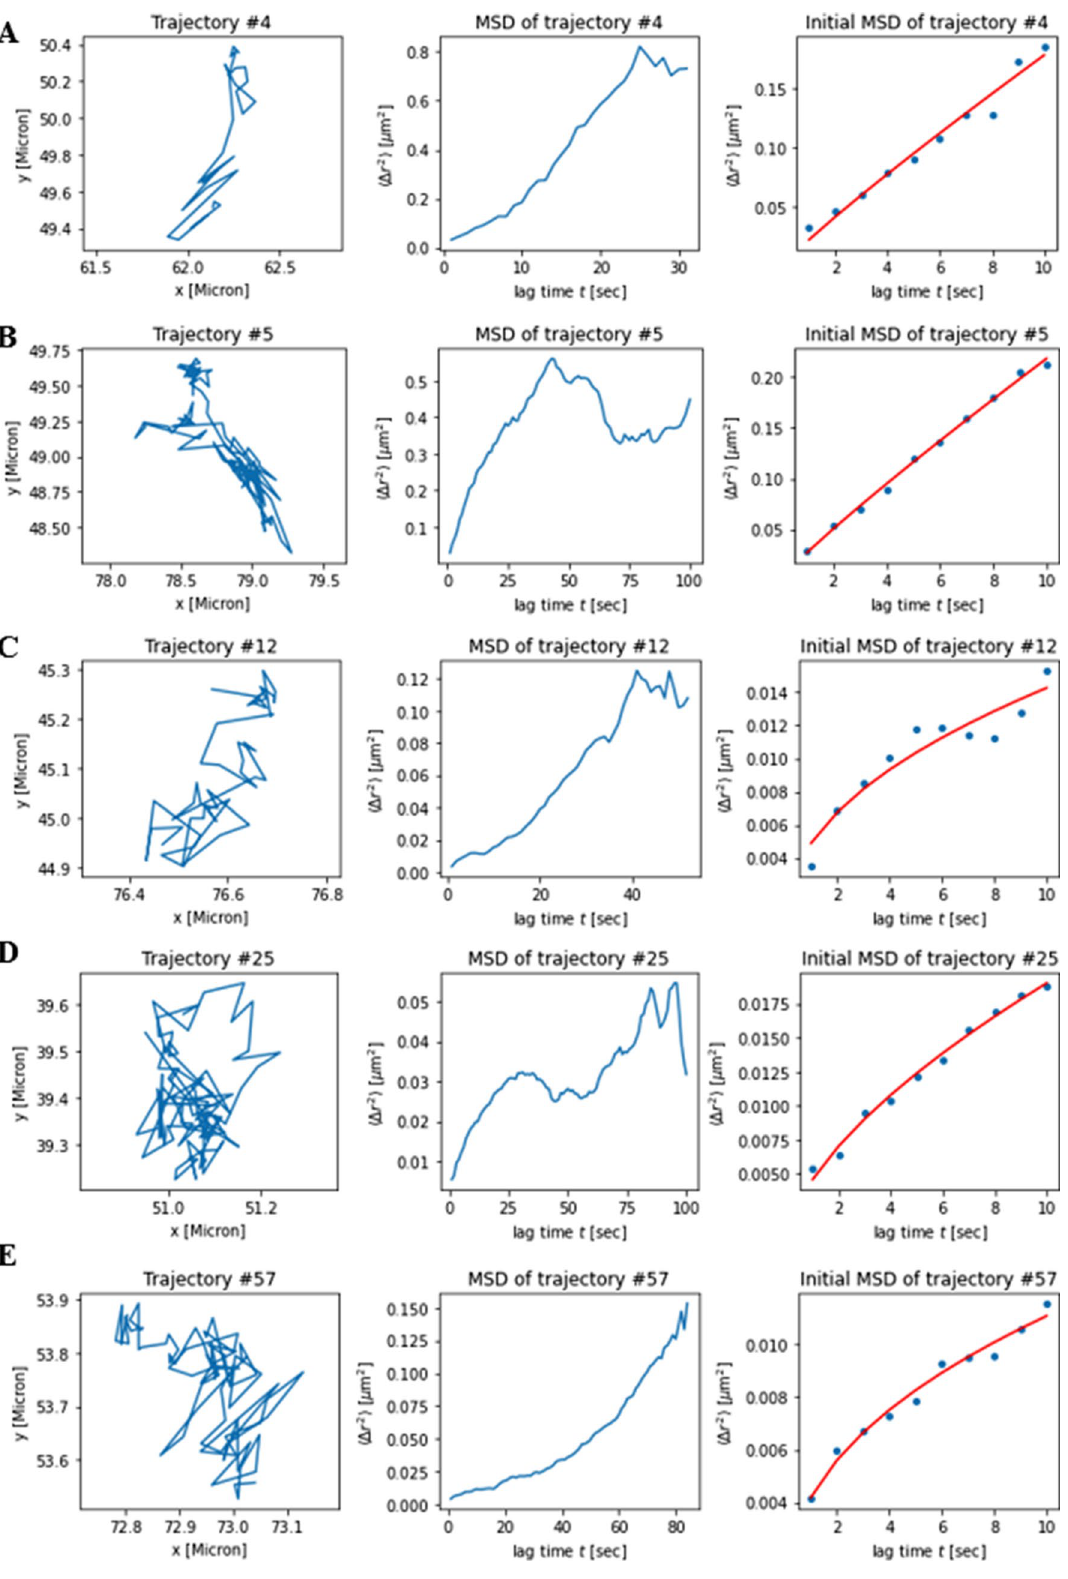
Figure 9. Selected trajectories of dynamic membrane contact sites and their analysis. MCSs identified in a single cell (‘cell1’, compare Fig. 7–8) were analyzed by single particle tracking revealing their trajectories (left panels), from which the time-averaged mean square displacement (MSD) was calculated (middle panels). The MSDs for the first 10 s were fit to an anomalous diffusion model, according to Eq. (1) in Materials and Methods (right panels; blue dots = data, red lines = fit). See text for further